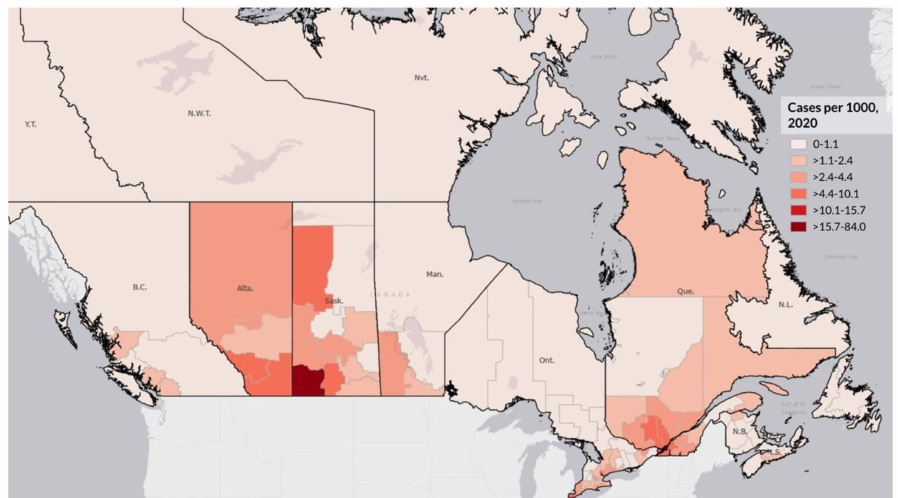
Figure 2. Logged COVID-19 Cases per 1000 in 2020 by Canadian Health Region.